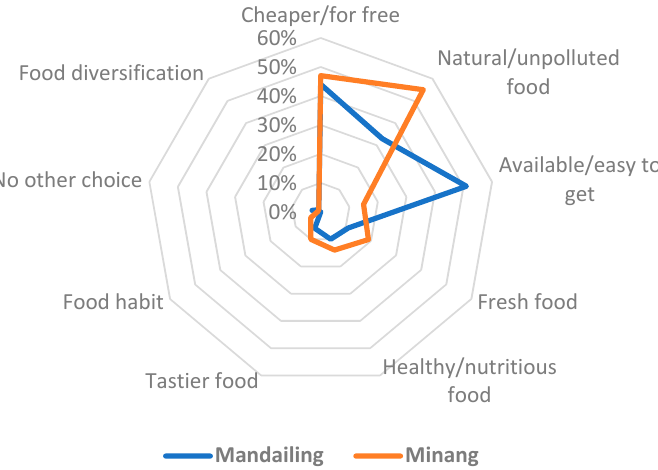
Figure 7. Motivations for consuming wild food plants (% of women).